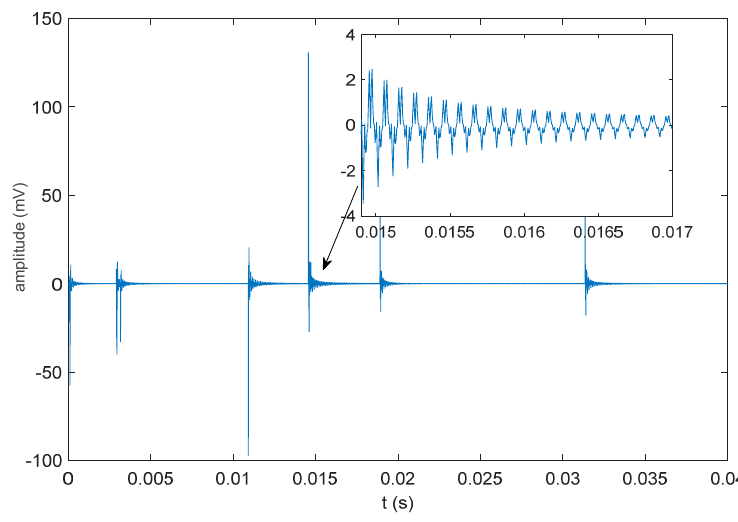
15 of 22 Figure 13. Oscillogram of the sound source signal.